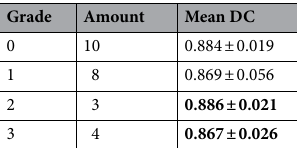
Table 10. DC of non-fractured vertebrae and vertebrae with fractures of different grade. Bold values indicates maximum and minimum values of the corresponding column or